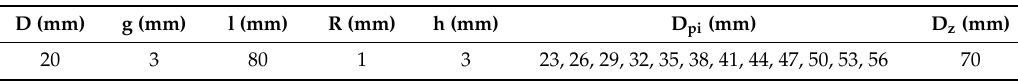
Table 1. Analyzed parameters of incremental radial extrusion of the flange (denotations according to Figure